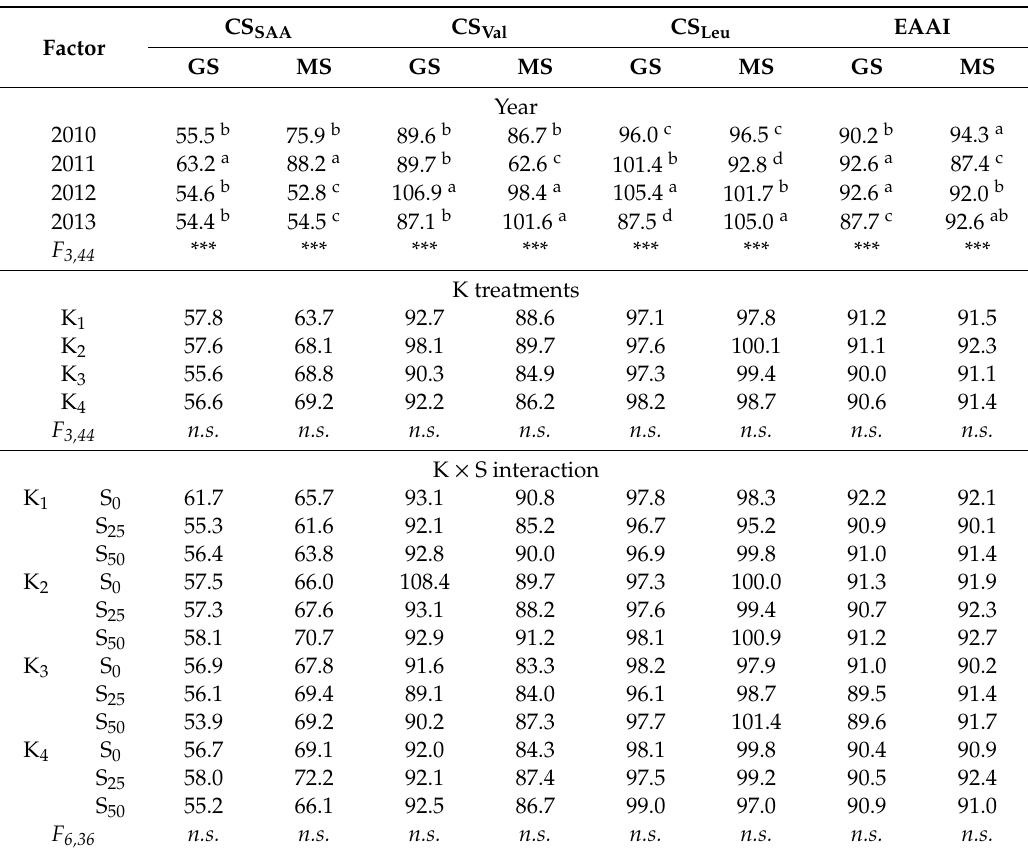
Table 7. Chemical scores (CS) and essential amino acid indices (EAAI) of faba bean crude protein at two stages of seed maturity. GS, immature seeds; MS, mature seeds. CS SAA CS Val CS Leu EAAI Factor